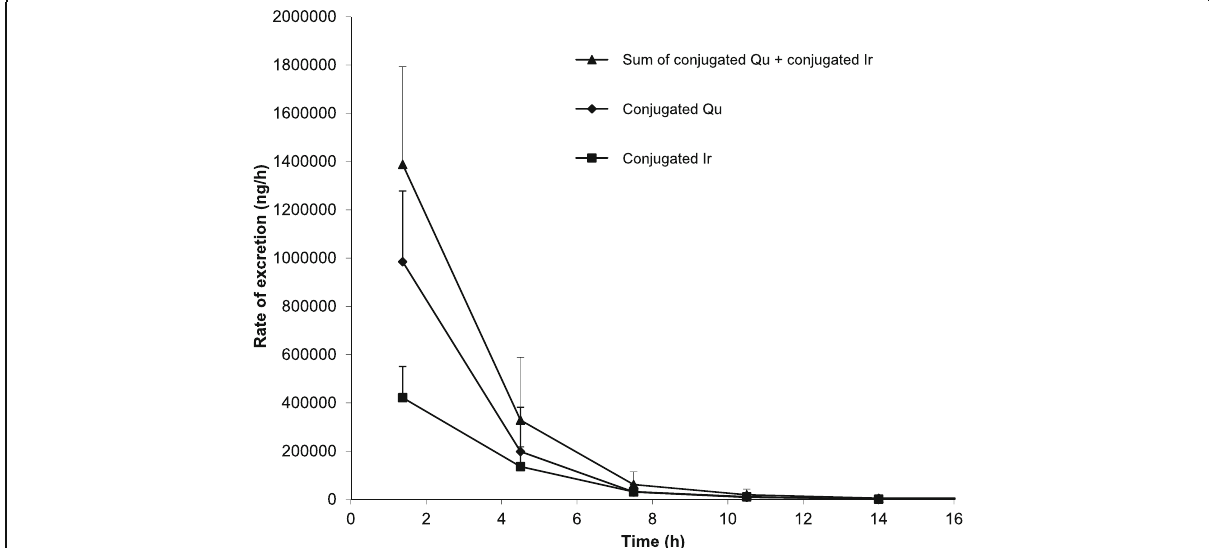
Fig. 5 Mean rate of Qu excretion in urine – time profiles following intravenous administration of a dose with reference to 250 mg/m 2 of human body surface area for conjugated metabolites of Qu, conjugated metabolites of Ir and for total conjugated metabolites of Qu and